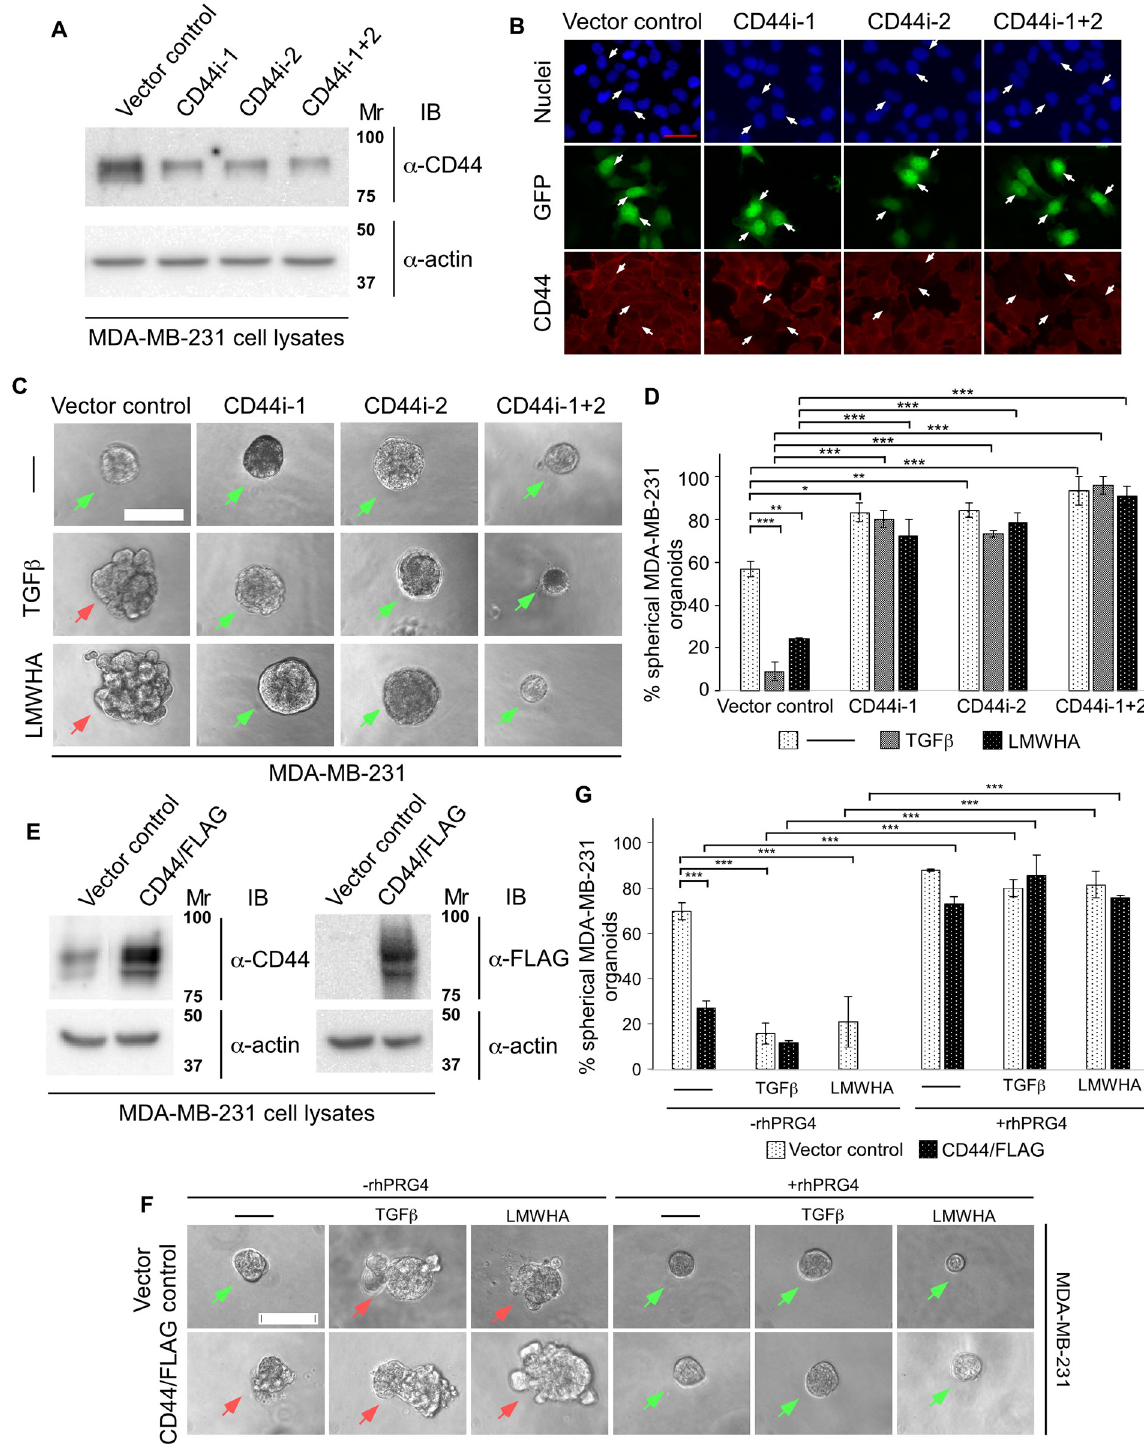
Fig 5. CD44 is crucial for TGF β -induced invasiveness in MDA-MB-231 cells. (A) CD44 immunoblot of lysates of MDA-MB-231 cells transfected with the pU6 RNAi vector (vector control), or the plasmids CD44i-1, CD44i-2, alone or together (CD44i-1+2) that expresses shRNAs targeting two distinct sequences of CD44 mRNA. Actin was used as loading control. (B) Representative CD44, GFP and nuclei fluorescence microscopy images of MDA-MB-231 cells transfected as in A, and subjected to anti-CD44 indirect immunofluorescence (rat anti- CD44/anti-rat Alexa 647, red) and counterstained with Hoechst 33342 fluorescent nucleotide dye (blue) to visualize nuclei. GFP (green) signal indicate vector control or CD44 RNAi-1/2-transfected cells. Arrows show examples of vector (left), CD44i-1 (2 nd column), CD44i-2 (3 rd